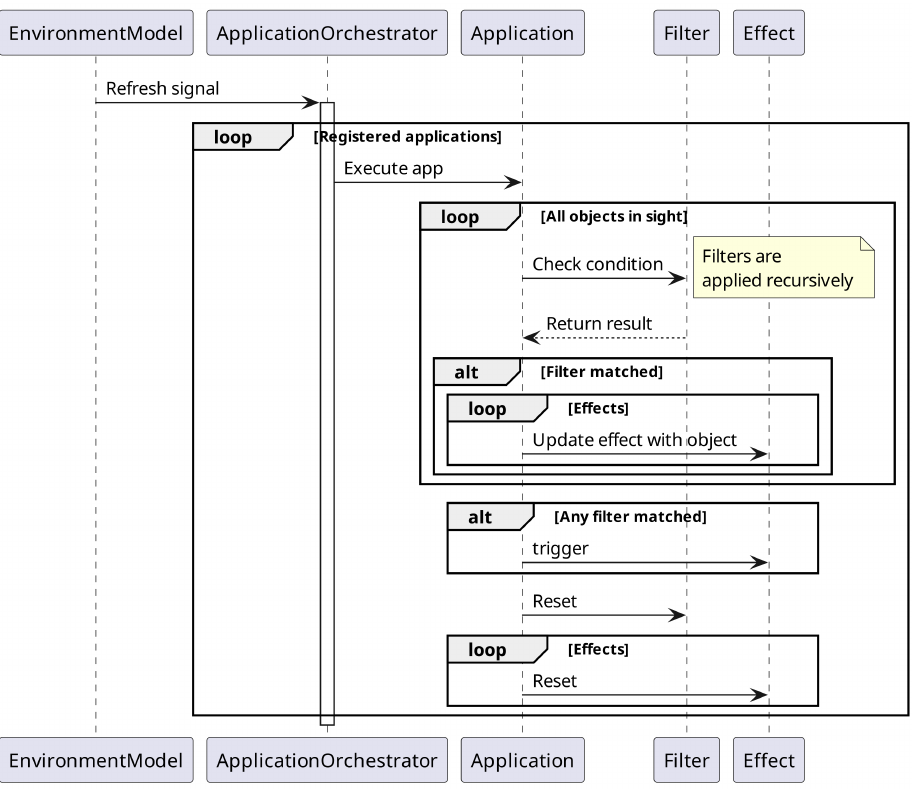
Figure 1. Sequence diagram of general ADASApp